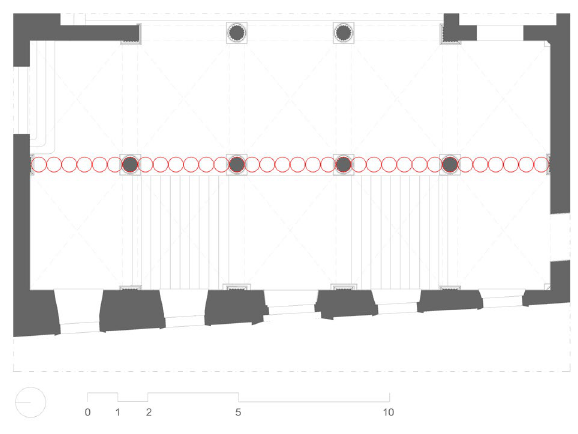
Figure 3 . Dimensional analysis of the atrium floor plan.